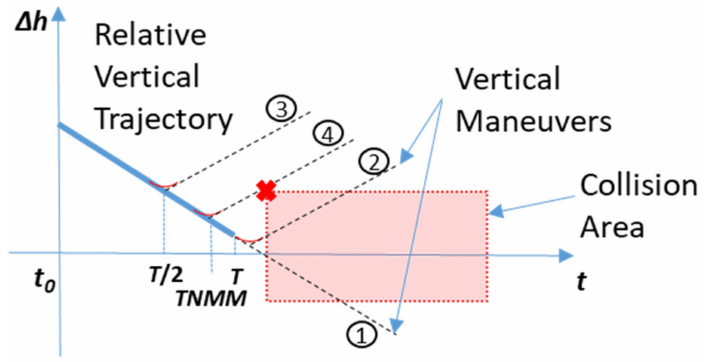
Figure 10. Computation of TNMM for horizontal